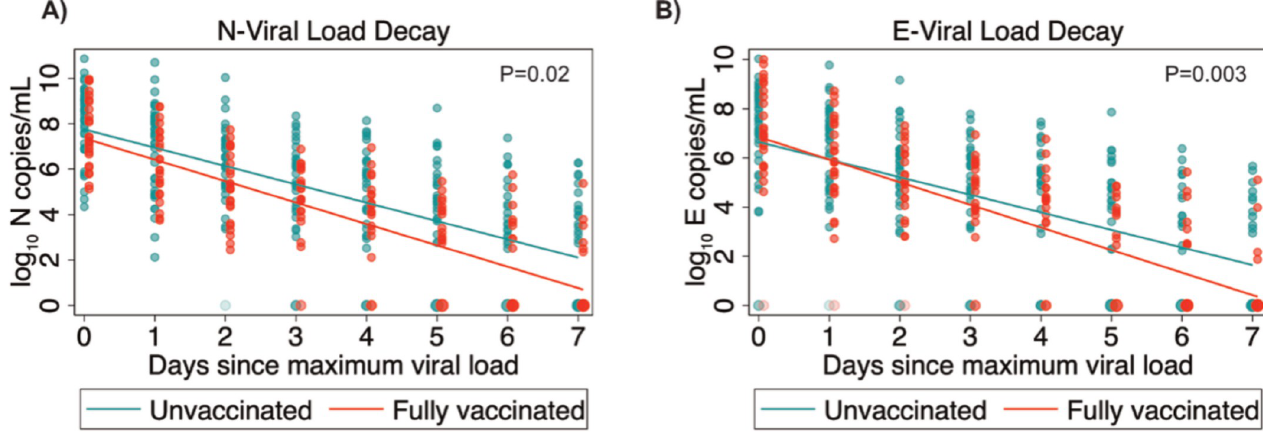
Fig 2. Dynamics of viral RNA decay, by vaccination status. Mixed effects model predicting mean viral RNA load of N (A) and E (B) targets longitudinally in unvaccinated and vaccinated participants. The analysis was done from the maximum detected viral RNA load of each participant (day 0) over seven days. Linear slopes were fitted to the data from vaccinated and unvaccinated groups and the P value for the significance of the interaction between vaccination status and time is shown. The color gradient of dots along the x axis represents increased proportions of specimens with no detectable viral RNA.